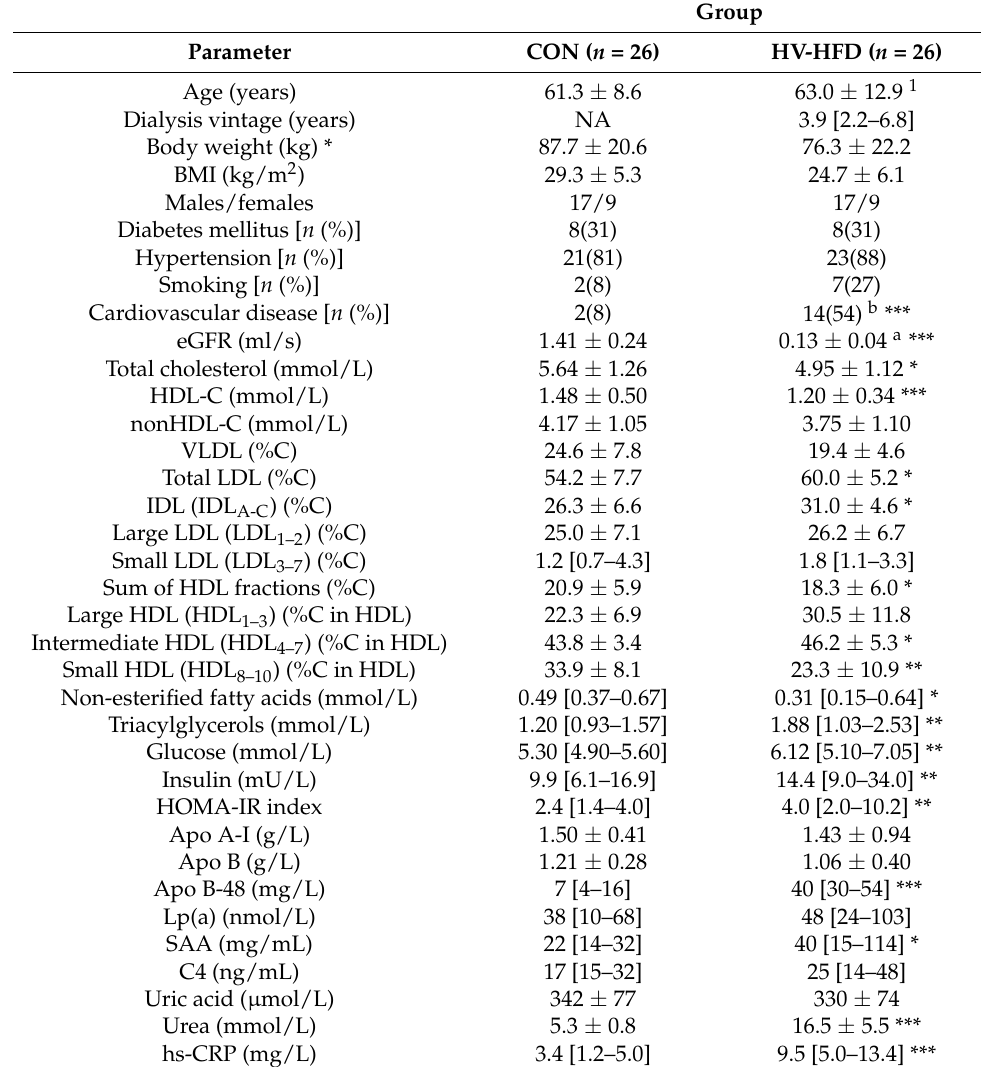
Table 1. Basic anthropometric and selected biochemical parameters of the studied